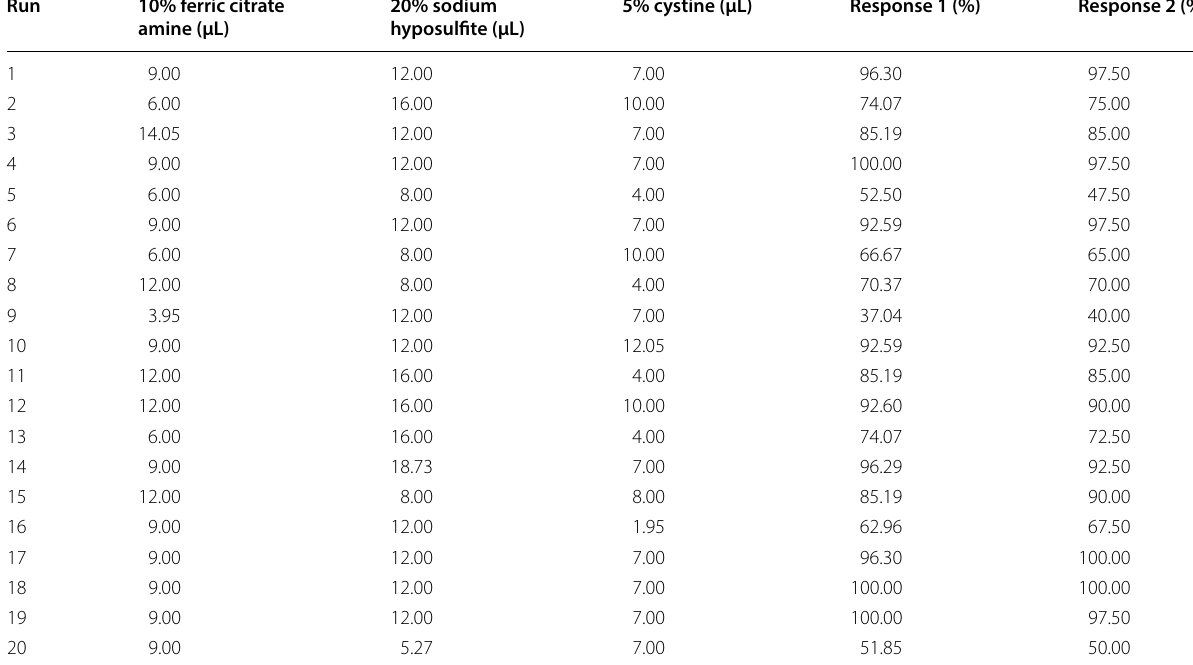
Table 2 Predicted responses to central composite design with three independent variables